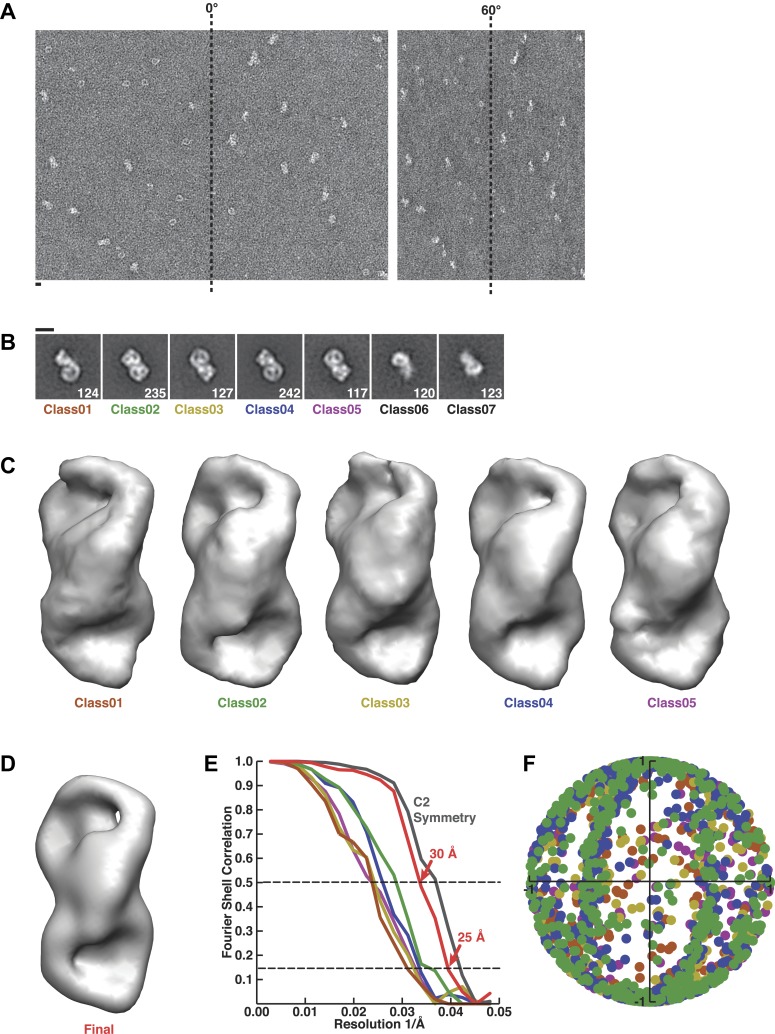
Random conical tilt reconstruction and refinement.(A) Representative fields from a random conical tilt pair of particles assembled with Rev-RRE, Crm1, and RanGTP. (B) Class averages from untilted particles used for random conical tilt. Particle numbers are inset in each image. Classes six and seven were observed with lower concentrations of sample and resemble partially disassembled complexes. Scale bars show 10 nm. (C) Volumes from each class after random conical tilt refinement show similar features among all classes suggesting the classes are different views of the same particle. The volume from the final reconstruction is shown in (D). (E) Fourier shell correlation curves for each random conical tilt class and the final reconstruction. The boost in Fourier shell correlation when C2 symmetry is applied during refinement confirms the symmetric arrangement of bowl-like densities. (F) Angular distribution from projection matching shows no major gap in Euler space.